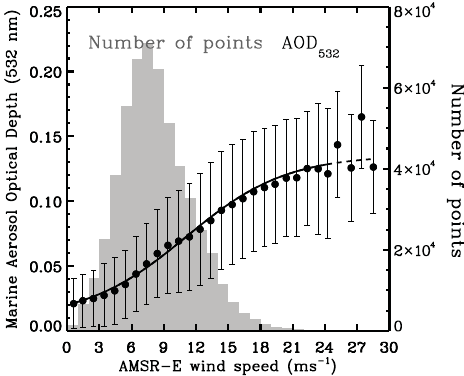
Fig. 5. The relationship between CALIPSO AOD 532 and AMSR-E wind speed for 15 selected regions over the time period of June 2006 to April 2011. The analysis is based on a total 539, 549 collocated data points of AOD and wind speed. The number of available data points for each wind speed bin is plotted at the background in grey color. Dotted line indicates that the AOD – wind speed relation- ship for U 10 > 24ms − 1 is based on limited number of data points. Circles and error bars show mean values and standard deviation of AOD for each 1ms − 1 wind speed bin, respectively. Logistic re- gression relationship between AOD 532 and wind speed is shown with the solid black